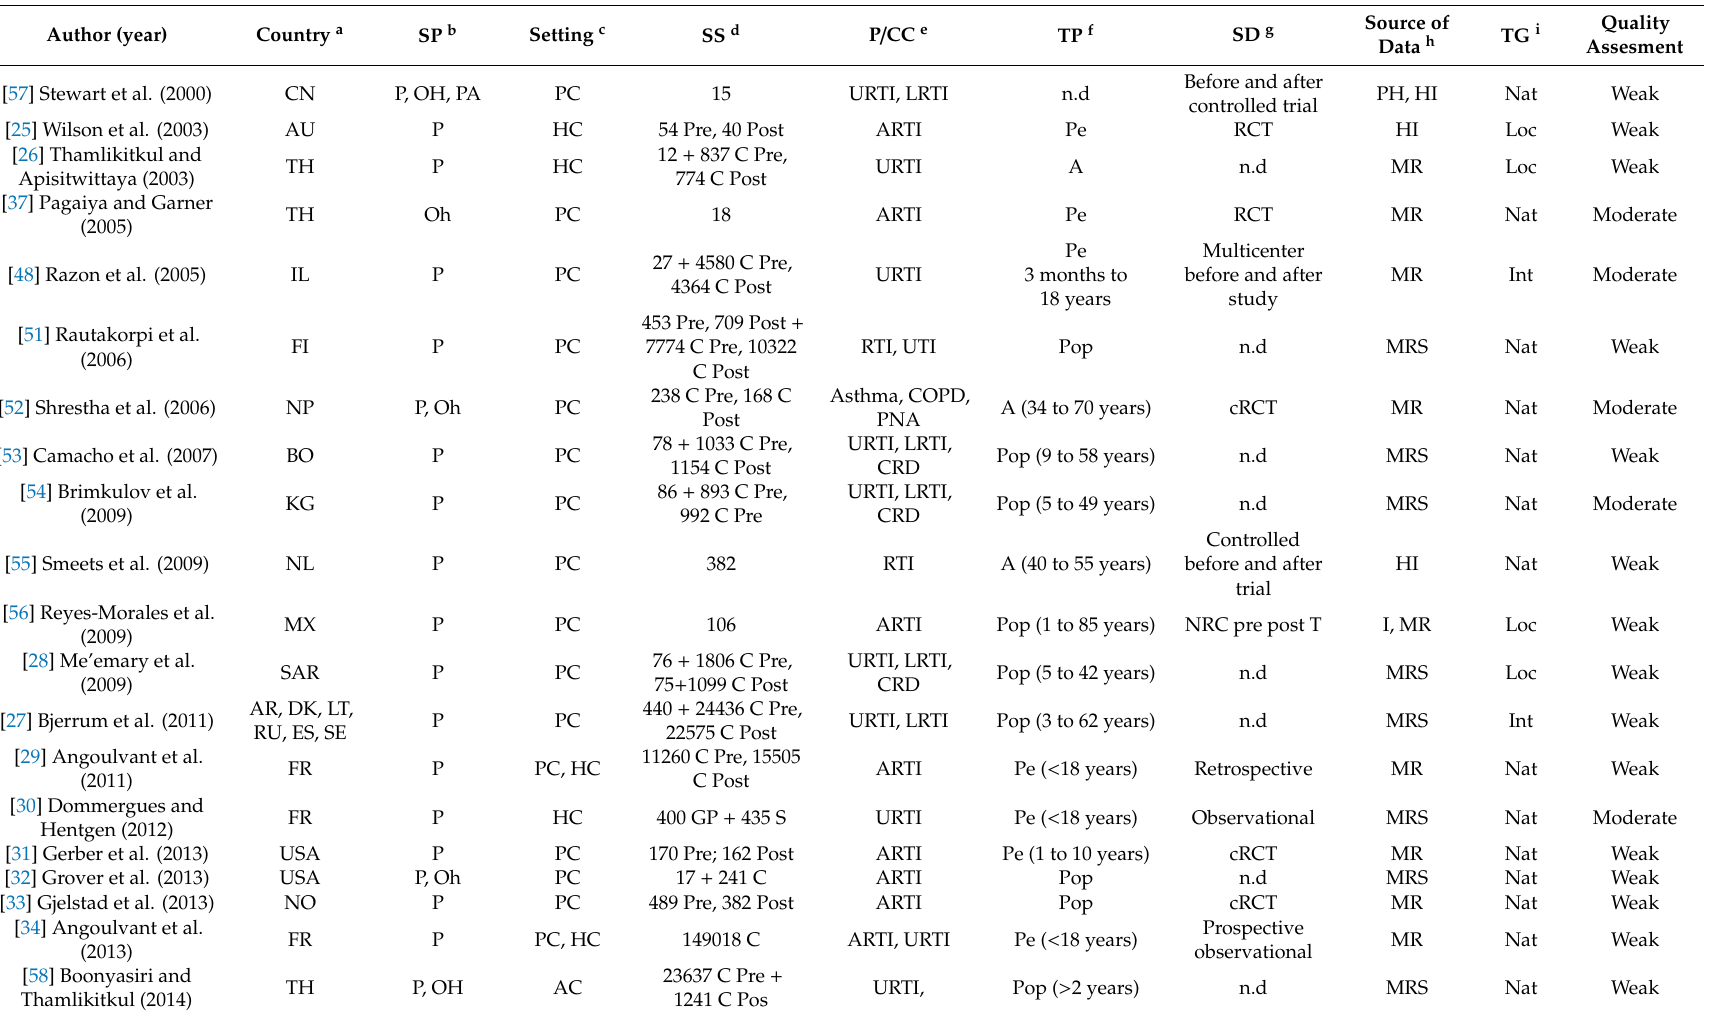
Table 1. Summary of the characteristics of the included